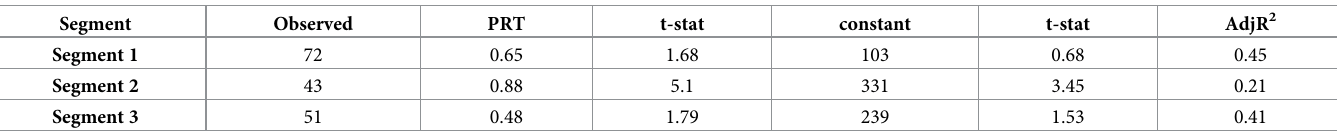
Table 8. Route U32 previous running time